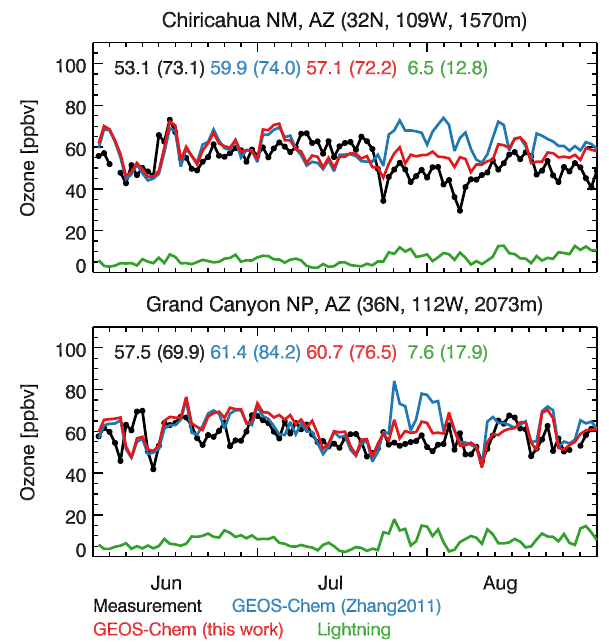
Figure 6. Time series of measured and simulated daily maximum 8h average (MDA8) ozone concentrations at Chiricahua NM and Grand Canyon NP (both in Arizona) in summer (June–August) 2007. Measurements (black line) are compared to model results from the Zhang et al. (2011) simulation (blue line) and from this work (red line). Also shown are simulated ozone enhancements from lightning as computed by the difference between our stan- dard simulation and a sensitivity simulation with lightning emis- sions turned off (green). The mean (maximum) concentrations for the time period are shown